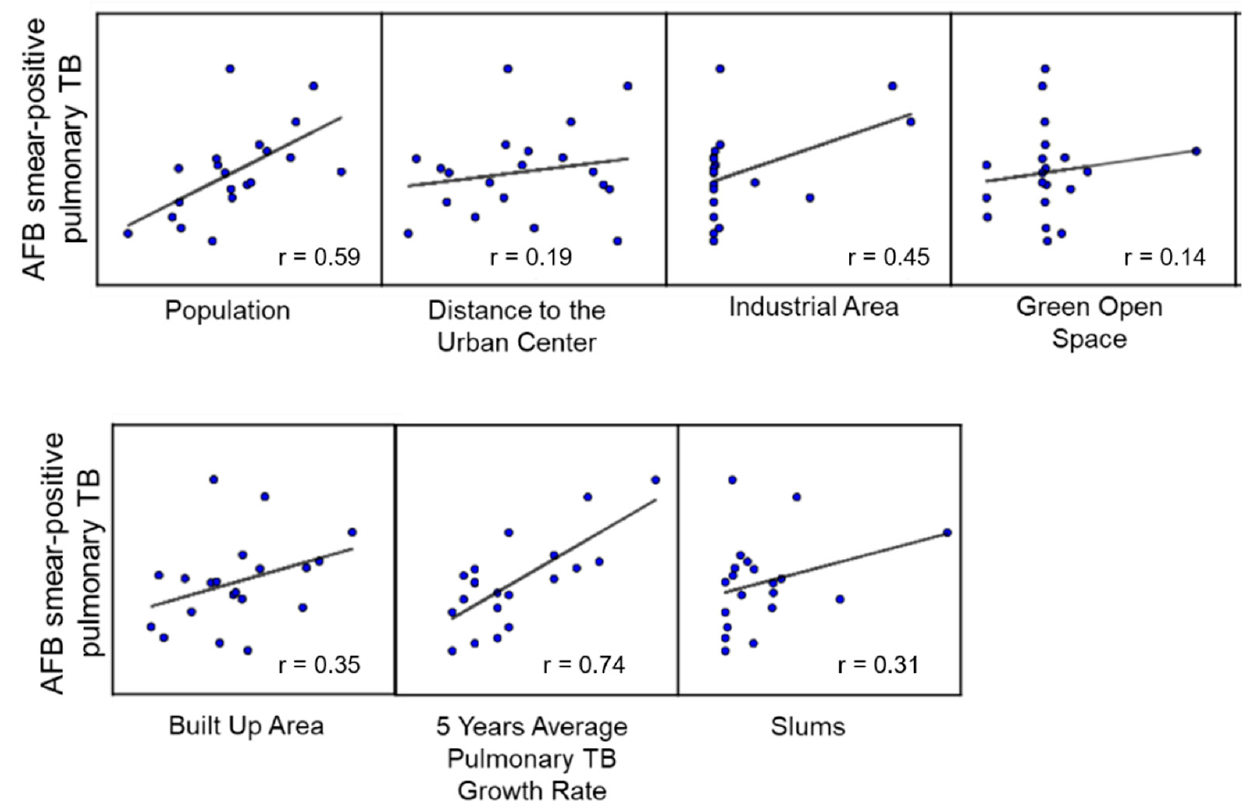
Figure 2. Scatter plot and correlation coefficient of all explanatory variables.